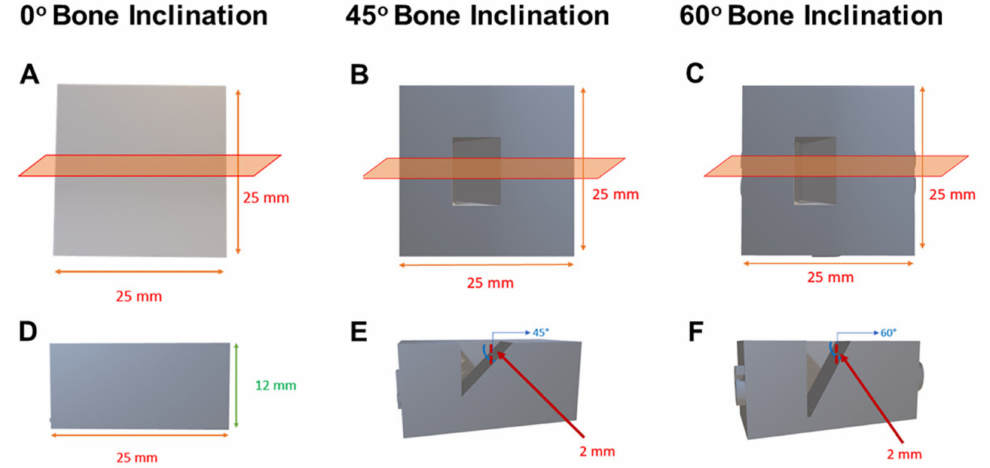
Figure 2. Bone models showing bone inclinations; 0 ◦ ( A , D ), 45 ◦ ( B , E ), and 60 ◦ ( C , F ). ( A – C ) are top view and ( D – F ) are side view.